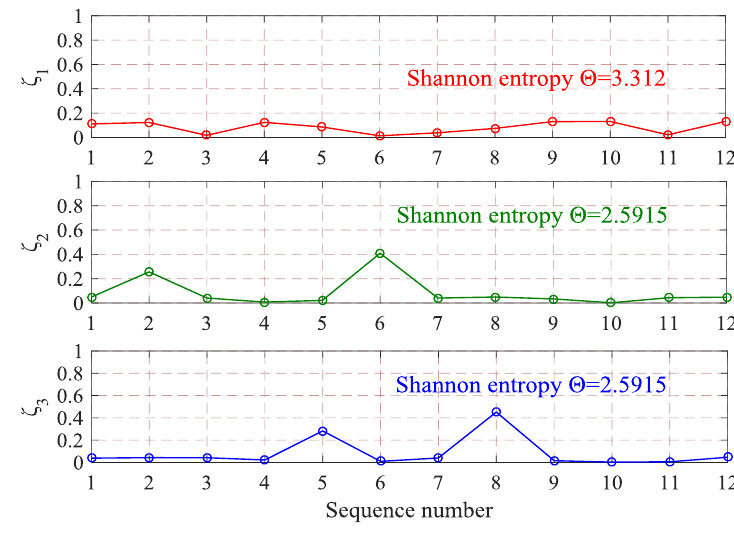
Figure 5. Incomplete description of Shannon entropy.